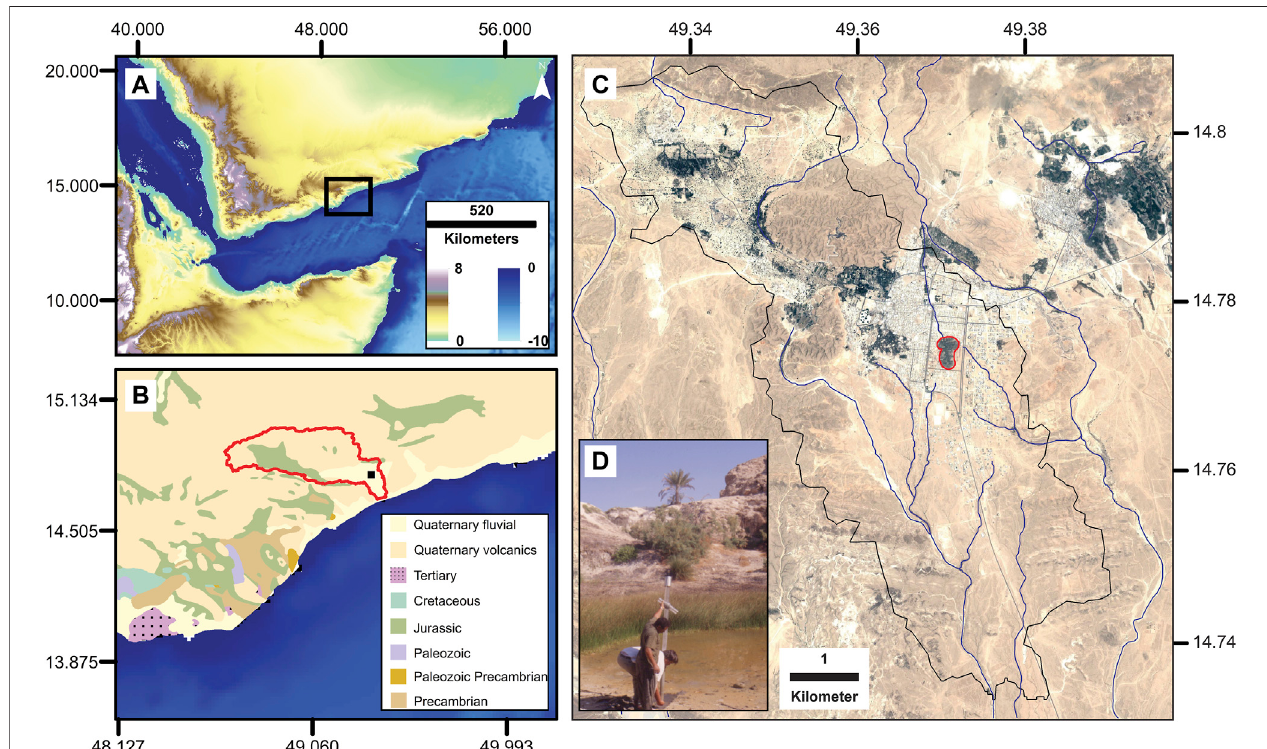
FIGURE 1 | (A) A SRTM 30 m elevation map of the SW part of the Arabian Peninsula with the studied area in Southern Yemen highlighted in a black square. (B) Geologicalmapofthestudiedareamarkedin(a),highlightingtheWadiHuwairahwatershed(redpolygon)andthelocationofGayalelBazal(blacksquare)(modi fi edafter Pollastro et al., 1999). The black square stands for the Gayal el Bazal area. (C) Detailed map of the Gayal el Bazal area. Black polygon marks the Gayal el Bazal Lake watershed with the riverine network system. The lake location is marked by a red polygon (Google Earth image, 2004). (D) Field photograph showing lake setting and core collection using Livingstone piston